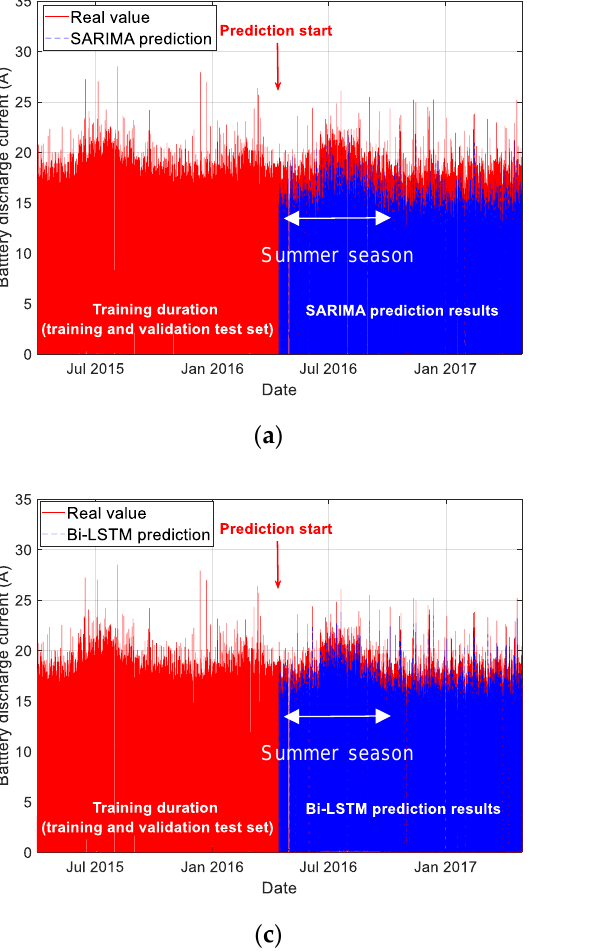
Figure 9. KOMPSAT-3A enlarged battery current prediction results: ( a ) discharge current; ( b ) charge current.